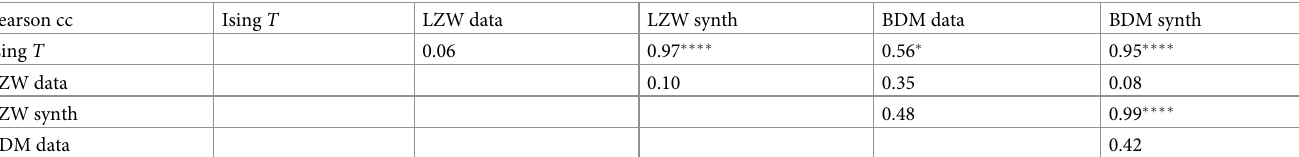
Table 2. Pearson correlation between different metrics. Pearson cc